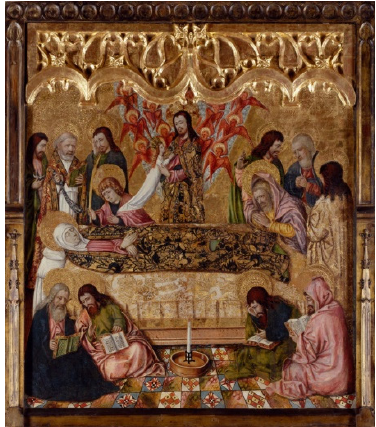
Figure 9. Joan Reixach, “Transit of the Virgin”, ca. 1460, Museum of Fine Arts of Valencia.